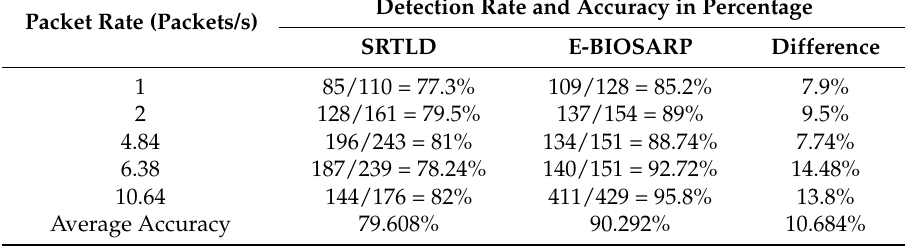
Table 9. Detection rate and accuracy comparison.